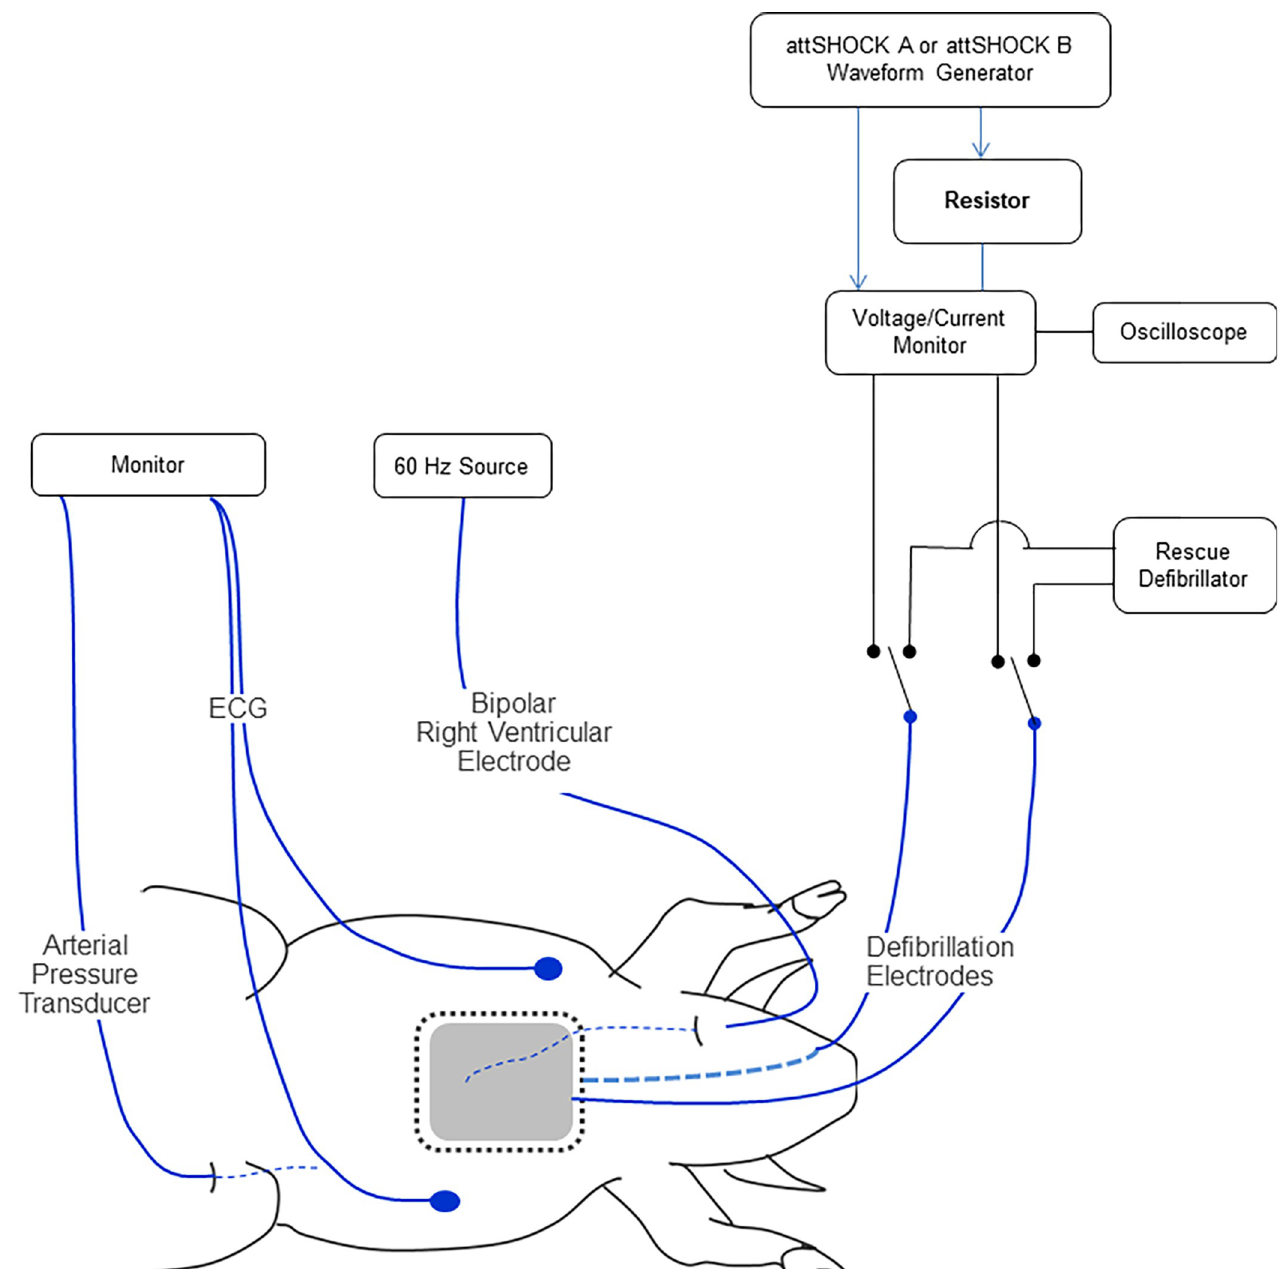
Fig 5. Animal Study #2 experimental setup. Image illustrating laboratory setup to enable ventricular fibrillation (VF) induction, monitoring and defibrillation in swine. ECG = Electrocardiogram, att = attenuated.